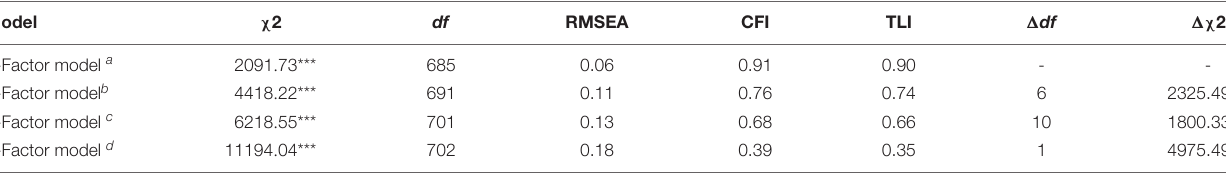
TABLE 3 | Chi-square difference tests and fit statistics for alternative measurement models. Model